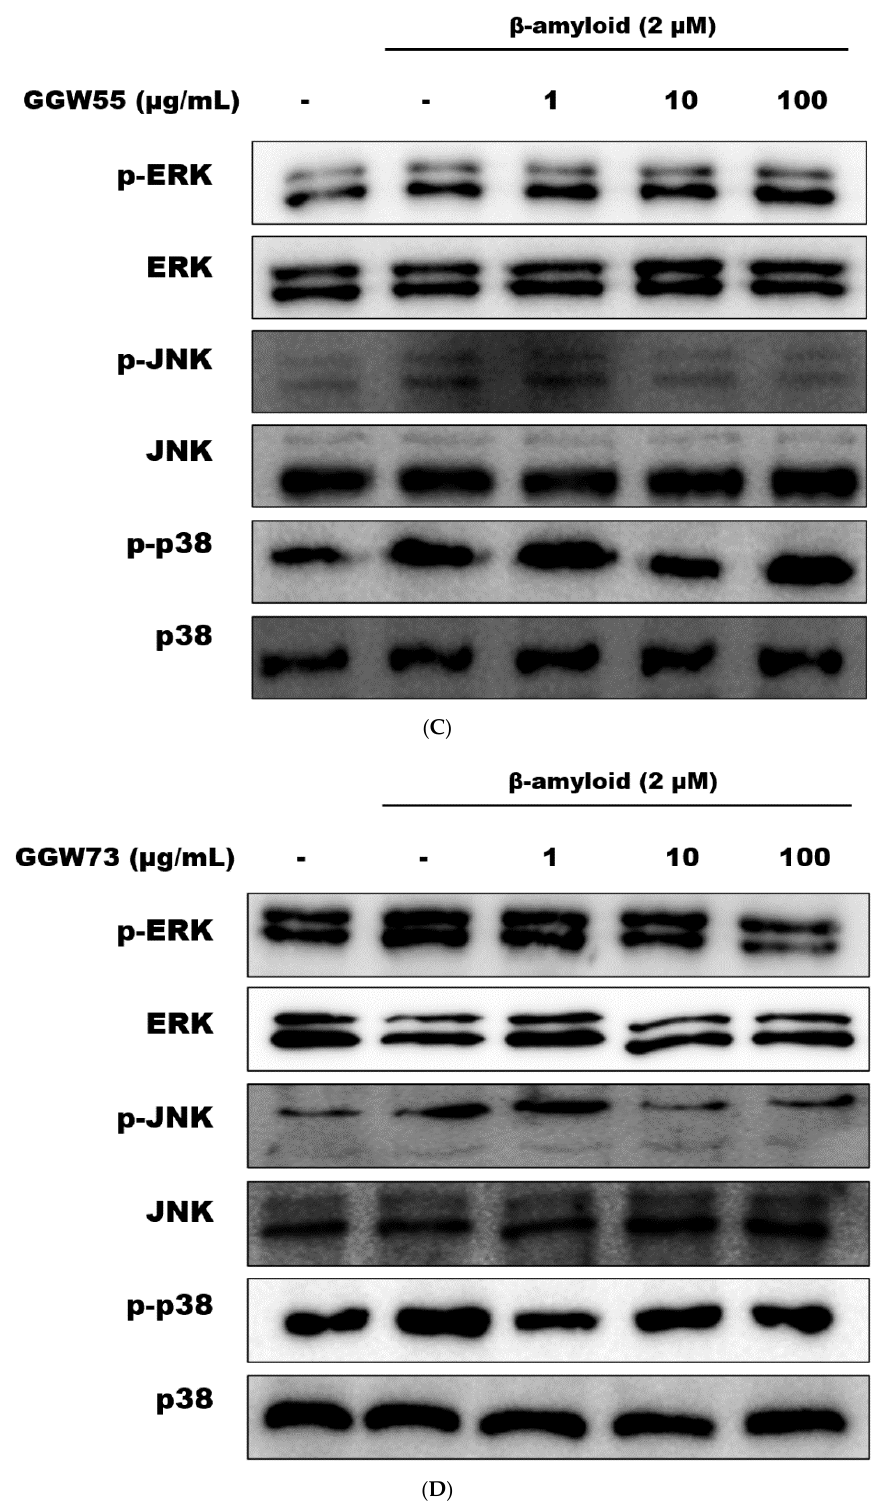
Figure 4. The regulatory effect of GGW on A β -stimulated MAPKs expression on neuronal cells. The regulatory effect of GGW55 and GGW73 on A β -stimulated MAPKs expression on SH-SY-5Y cell and SK-N-SH cell. The cells were treated with GGW55 and GGW73, after 1 h A β (2 µ M) were treated for 45 min. ( A ) MAPKs expression on SH-SY-5Y cell with GGW55. ( B ) MAPKs expression on SH-SY-5Y cell with GGW73. ( C ) MAPKs expression on SK-N-SH cell with GGW55. ( D ) MAPKs expression on SK-N-SH cell with GGW73. The MAPKs expressions were measured using Western blot